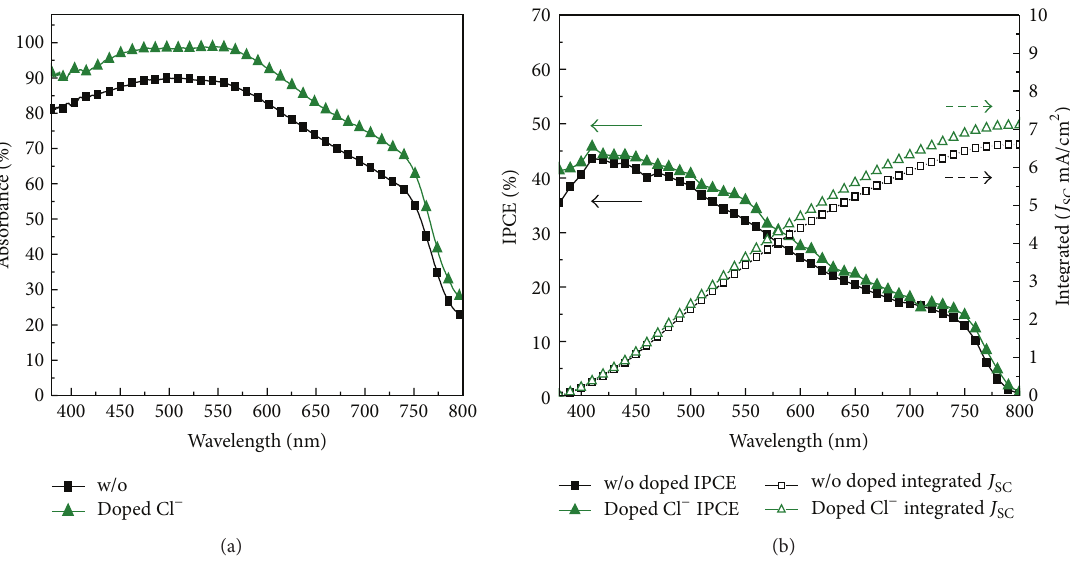
Figure 5: Perovskite film and device performance. (a) The UV-vis spectra of FTO glass/cp-TiO 2 /mp-TiO 2 films filling with MAPbI 3 (black square)andMAPbI 3−𝑦 Cl 𝑦 (olivetriangle).(b)TheIPCEcurvesandcorrespondingintegratedphotocurrentcurvesofthedeviceswith/without doping Cl −